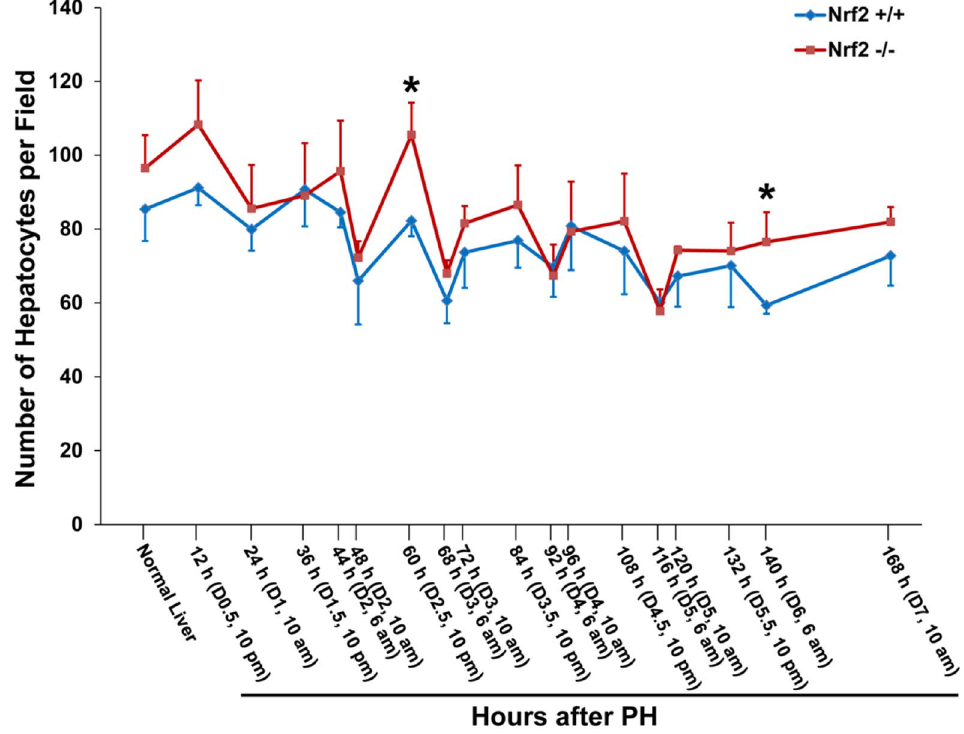
Figure 1. Changes in hepatocyte density after partial hepatectomy (PH) in Nrf2 + / + and Nrf2 2 / 2 mice. Livers were collected from the two genotype groups of mice at the indicated time points post-PH. Liver sections were prepared and subjected to hematoxylin and eosin staining. Hepatocytes were counted in five randomly chosen fields per liver section (400x magnification) with Image-Pro Plus software. The results are shown as the means per field 6 SD (n=3 to 5 mice/time point/genotype; *, p , 0.05 between Nrf2 + / + and Nrf2 2 / 2 mice).